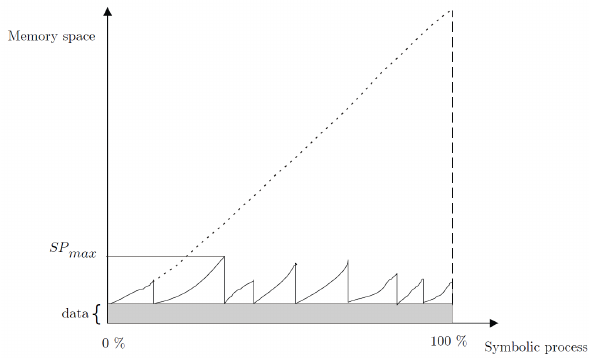
Figure 8. Memory allocation for a ROBOTRAN generation pro-